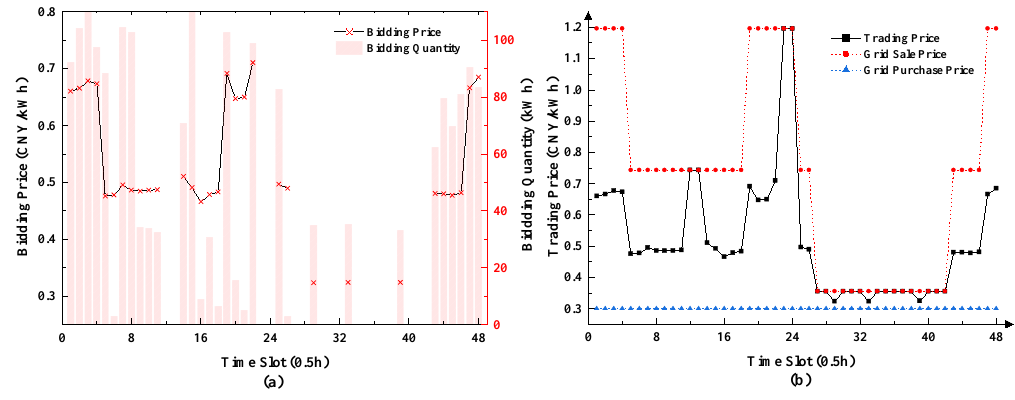
Figure 8. ( a ) Bidding price and quantity of MG 4; ( b ) actual trading price of MG 4. MG 9, which contains a large installed capacity of wind and solar power, has surplus energy throughout the whole trading cycle, and its bidding quantity is represented by the green bars in Figure 9. As a clean and cheap energy resource, the surplus energy injected into the market is urgently needed during specific intervals. From Figure 9, it can be observed that MG 9 reaches deals with other microgrids in almost all the time slots in peak and flat intervals. This trading result has greatly relieved the problem of the high energy supply pressure on the grid in peak periods. In the valley period for energy consumption, surplus energy is discarded or sold to the grid at a very low price.